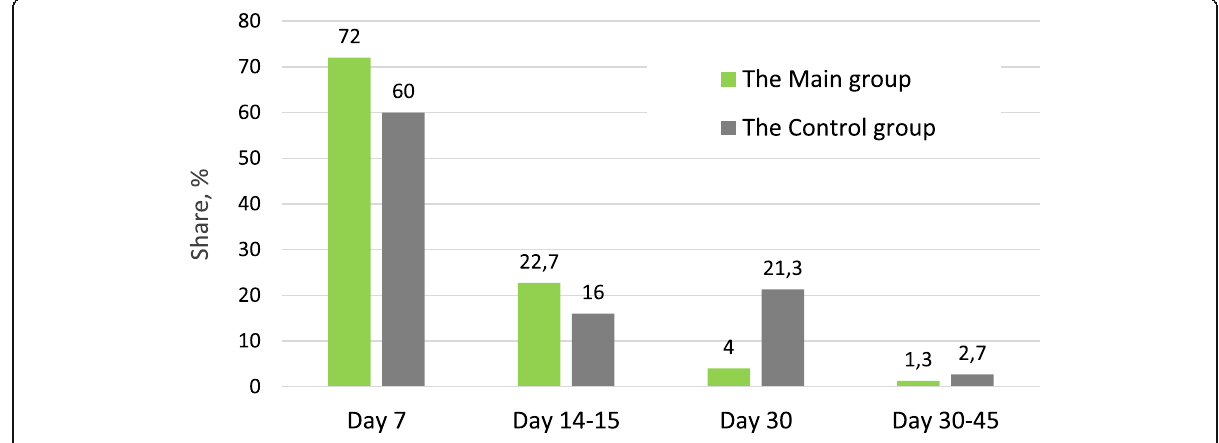
Fig. 1 Dynamics (%) of elimination of destroyed fragments of urinary calculi in the groups